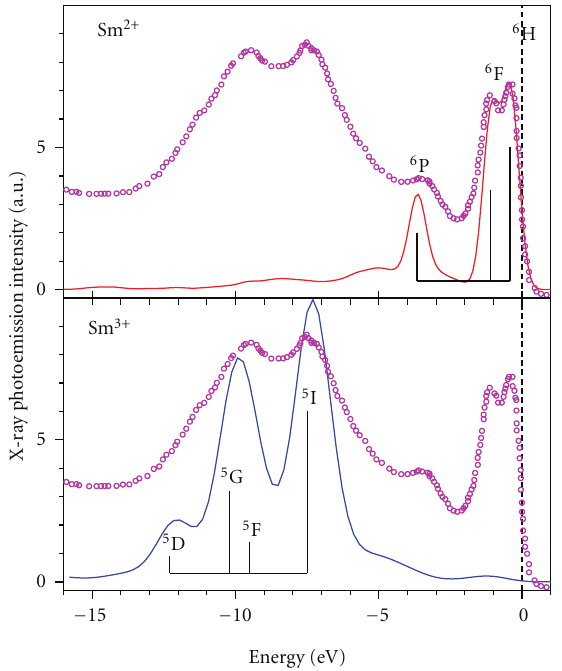
Figure 54: Comparison of the calculated 4 f DOS of SmB 6 using LSDA+ U approximation [349] with the experimental XPS spectra from [346] taking into account the multiplet structure of the 4 f 5 and 4 f 4 final states (see explanations in the text).